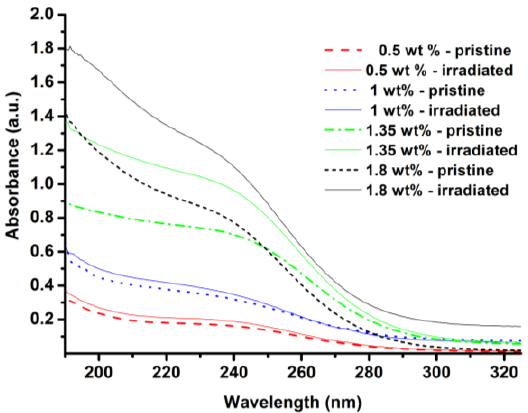
Figure 1. UV absorption spectra of preforms core before and after IR irradiation.